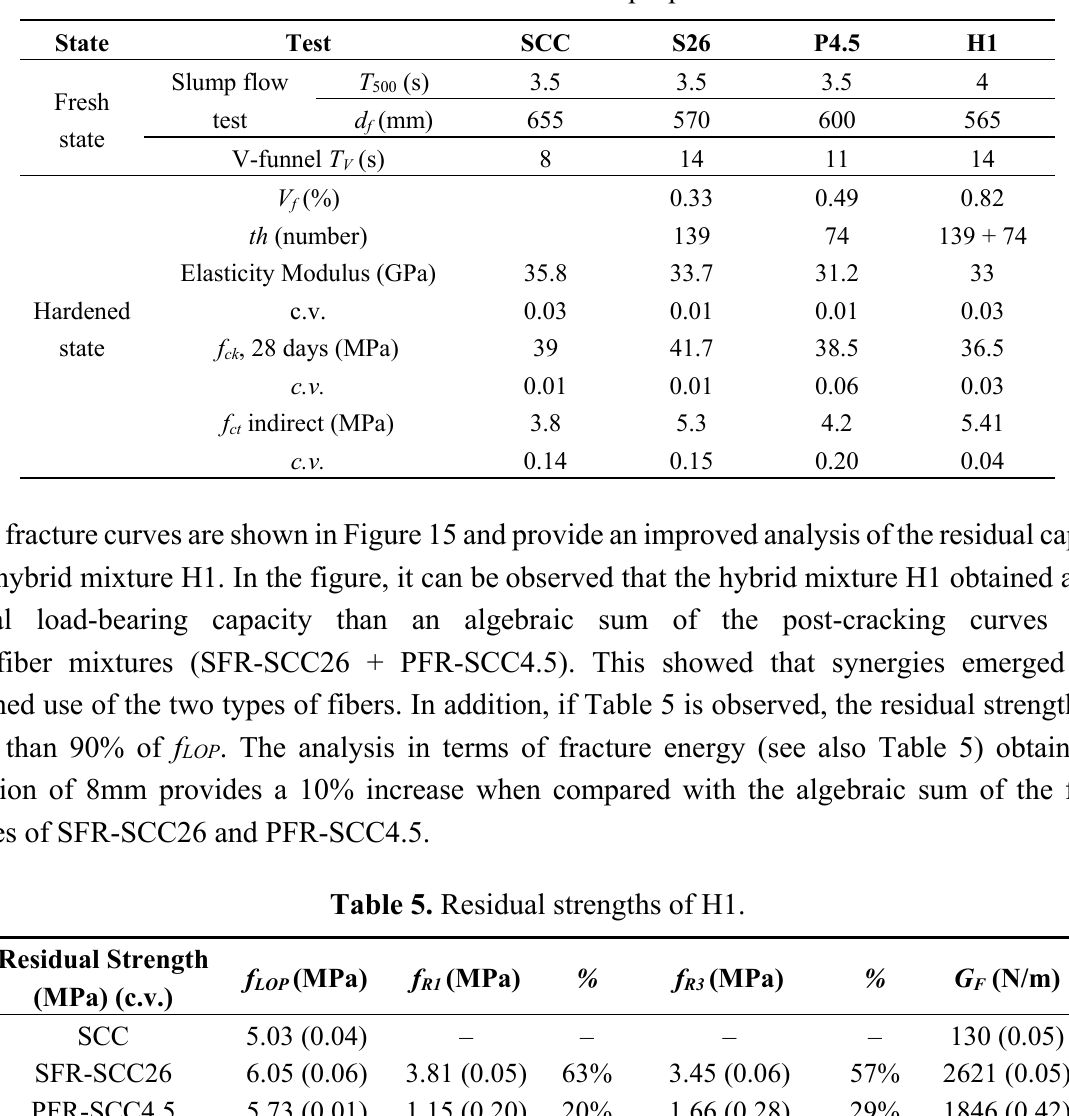
Table 4. Fresh-state results and mechanical properties of the mixture H1.